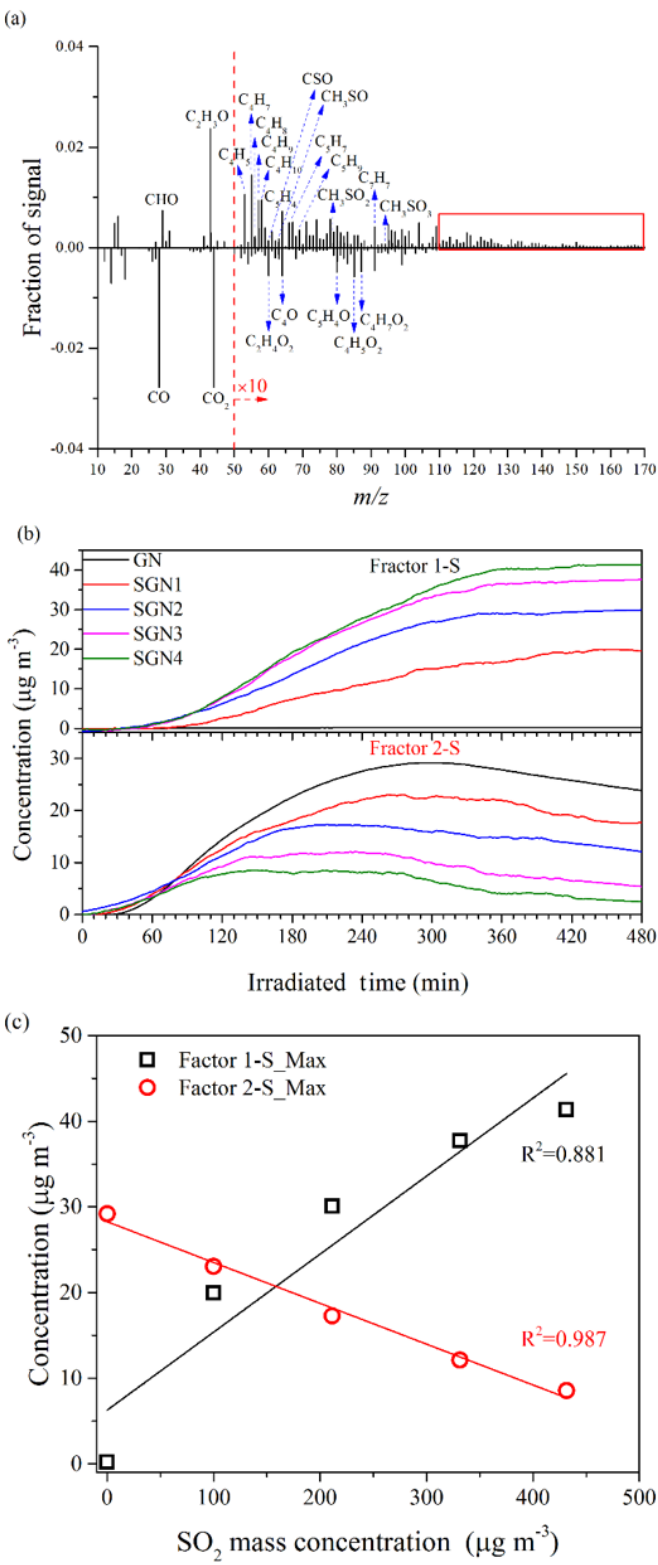
Figure 9. (a) Different mass spectra (Factor 1-S–Factor 2-S) between the two factors, (b) time series of the mass concentration, and (c) re- lationship between the concentration of SO 2 and the maximum concentration of the two factors identified by applying PMF analysis to the AMS data derived from the experiments at different concentrations of SO 2 (Exps. GN, SGN1, SGN2, SGN3, and